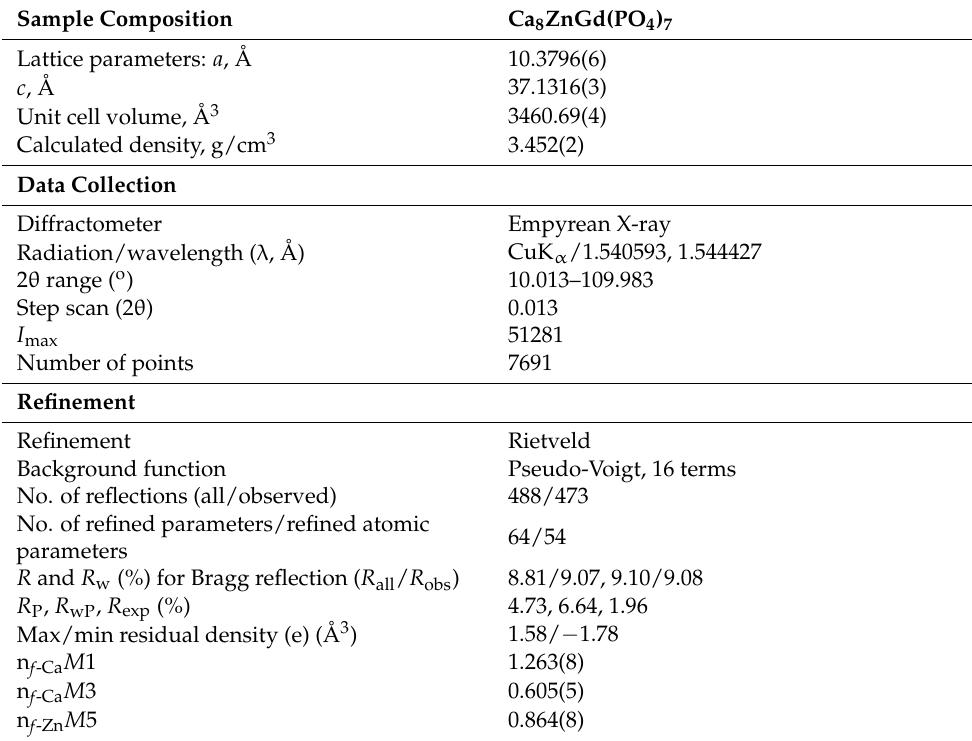
Table 2. Crystallographic data for Ca 8 ZnGd(PO 4 ) 7 (SG R 3 c , Z = 6, T = 293 K).